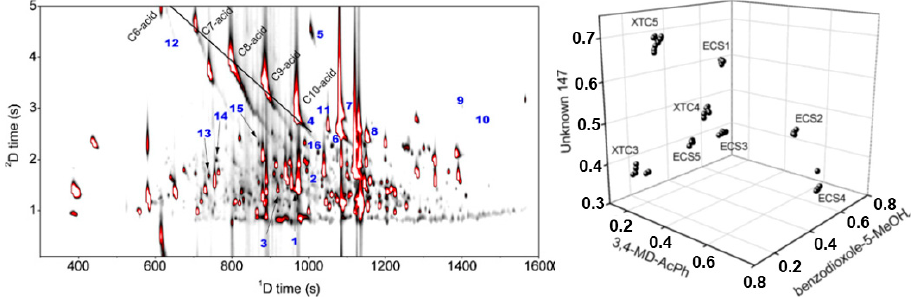
Figure 9. GC × GC-TOFMS volatile profile of an ecstasy sample, along with the location of the 16 compounds selected for the profile correlation and the identified fatty acids ( left ). 3D plot of the linear discriminant analysis (LDA) analysis with three selected compounds, showing the clear clustering of the eight groups of ecstasy samples ( right ). Source: adapted with permission from Mitrevski et al. [165].